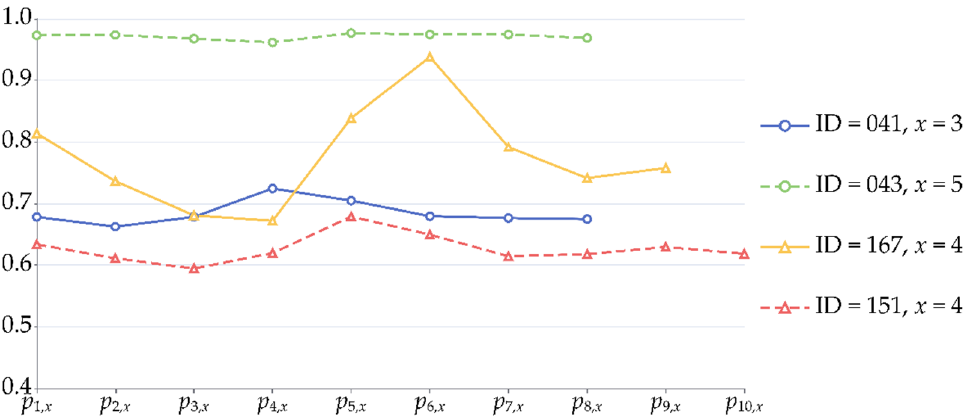
Figure 6. The inter-graph analysis of meta-path-based attention.